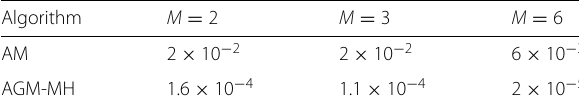
Table 6 Mean squared error (MSE) for the univariate Gaussian target in Section